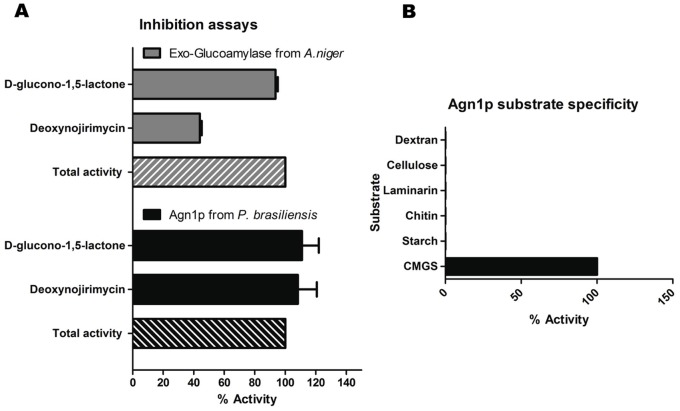

P.
brasiliensis Agn1p is a specific endo α-1,3-glucanase.(A) Inhibition profile of exo-glucoamylase from A. niger (gray) and endo-α-1,3-glucanase from P. brasiliensis (black). Note that none of the indicated inhibitors reduced Agn1p-his activity significantly, even at a high concentration of 250 µM. (B) Agn1p substrate specificity. Purified Agn1p-his was incubated with the indicated substrates at 1 mg/ml. Reactions were carried out at optimal conditions by triplicate.